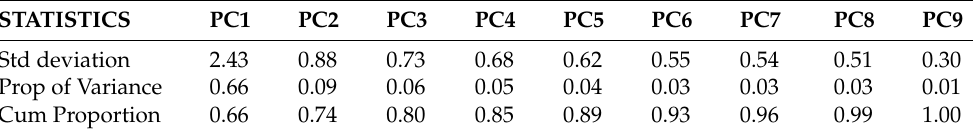
Table 2. % of variation explained by each component for the breast cancer data.